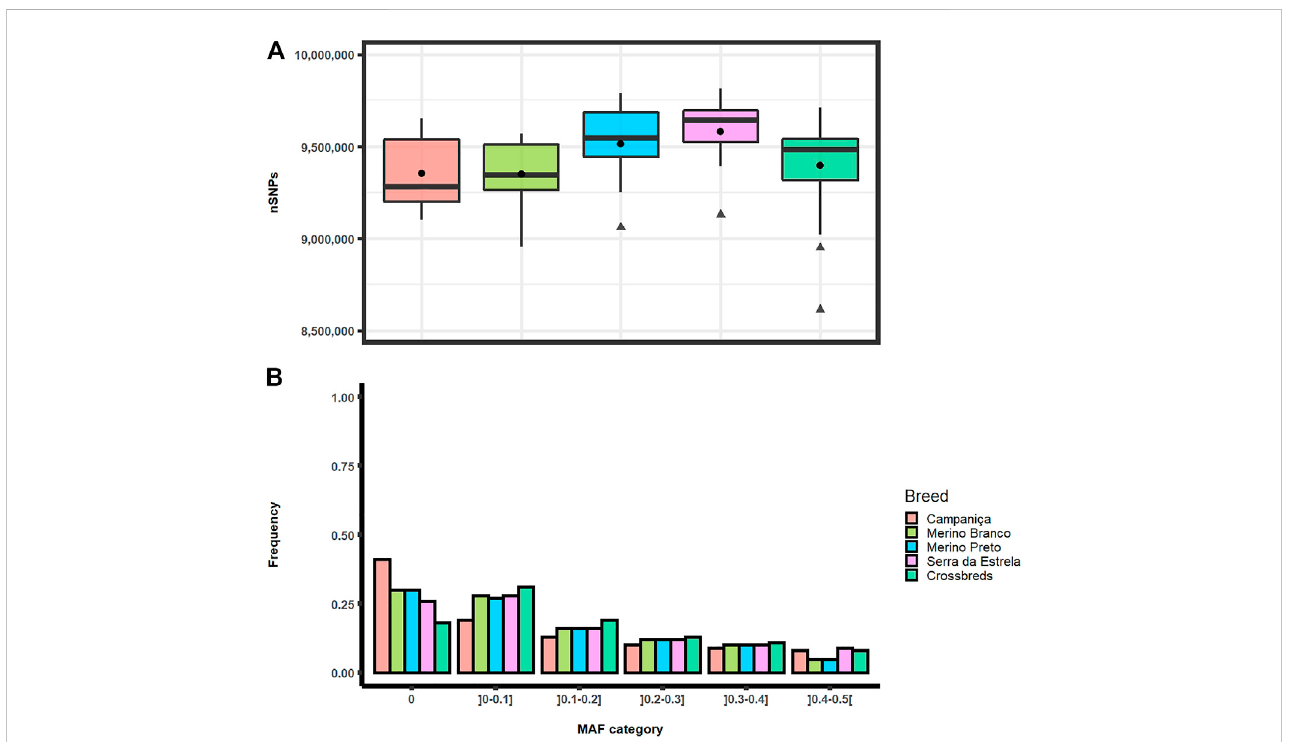
FIGURE 2 Distribution of single nucleotide polymorphisms in Portuguese sheep. (A) Boxplot graph of the total number of SNPs per individual observed in each population. Mean values are represented by black circles and outliers by triangles; (B) Frequency of minor allele frequency (MAF) by category in each breed.